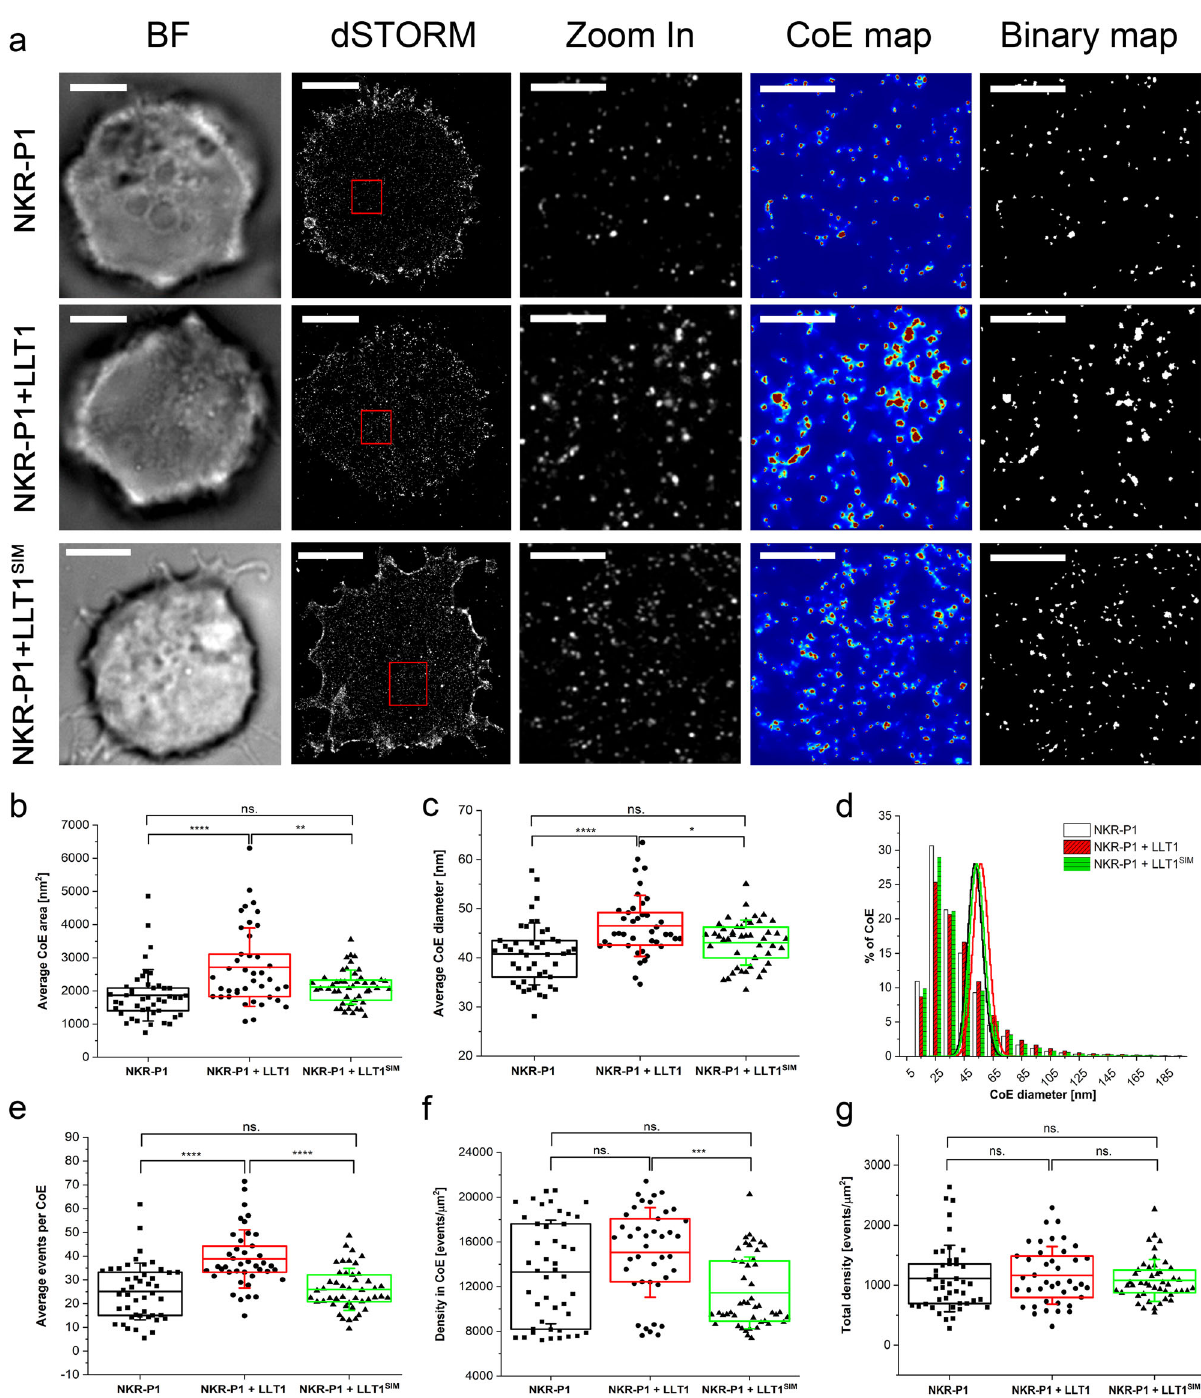
Fig. 6 | Soluble LLT1 affects NKR-P1 distribution on the cell surface. NKR-P1 stable transfectants were incubated in the presence or absence of soluble LLT1 or LLT1 SIM , and the cell surface distribution of NKR-P1 was monitored by super- resolution microscopy. a Representative bright fi eld (BF) and dSTORM images of full-length NKR-P1 HEK293 stable transfectants on PLL-coated slides incubated without (black) or with LLT1 (red) or LLT1 SIM (green), fi xed and stained with Alex- aFluor ® 647-labeledanti-NKR-P1mAb;scalebarsrepresent5 µ m.The10 µ m 2 regions (red boxes in dSTORM images) are magni fi ed and shown with corresponding clusters of fl uorescent events (CoE) maps and binary maps; scale bars represent 1 µ m. b – g Analysis of full-length NKR-P1 distribution relative changes induced by thepresenceofitsLLT1orLLT1 SIM solubleligands:averageclusterofeventsarea( b ),